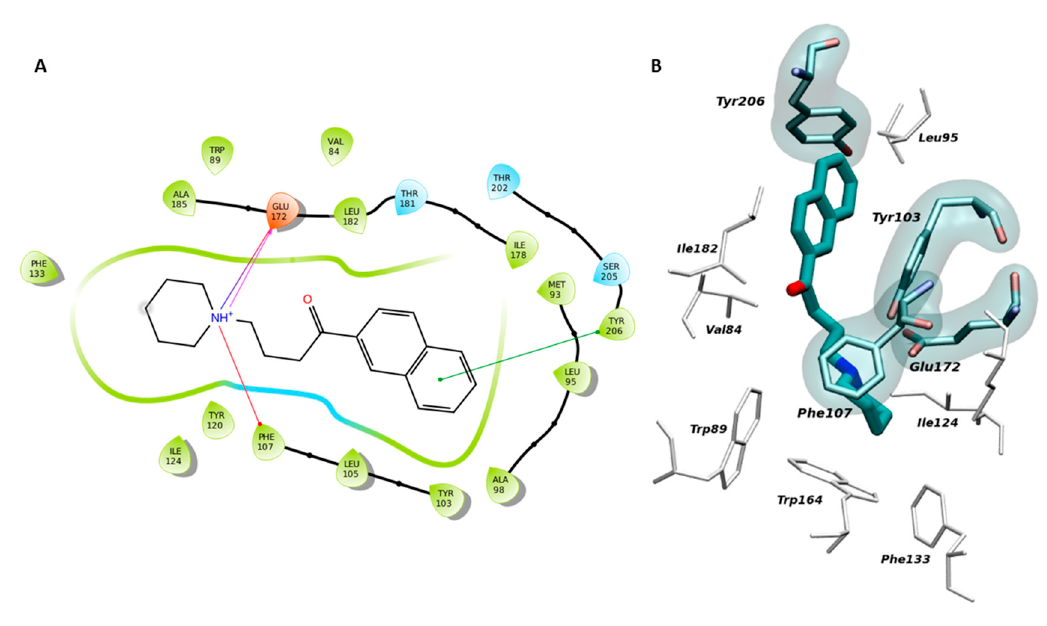
Figure 7. Binding mode of 11 in 2D space ( A ) and 3D space ( B ). The residues of the protein involved in hydrophobic interactions are reported in white